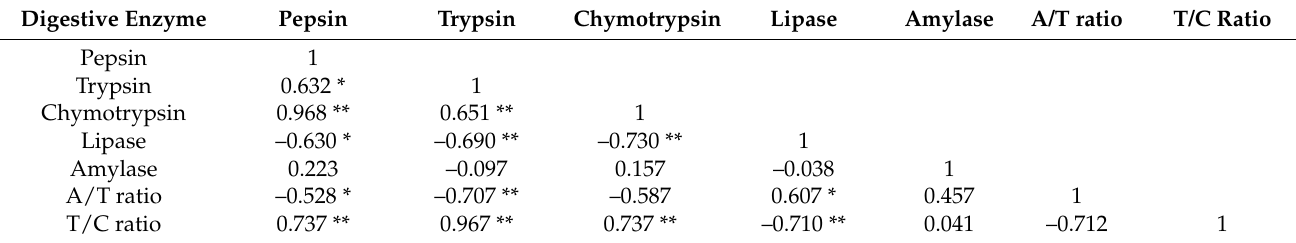
Table 2. Correlation coefficients ( r ) between each pair of fecal digestive enzymes. The values were calculated from experimental units across all feeding frequencies observed ( n =